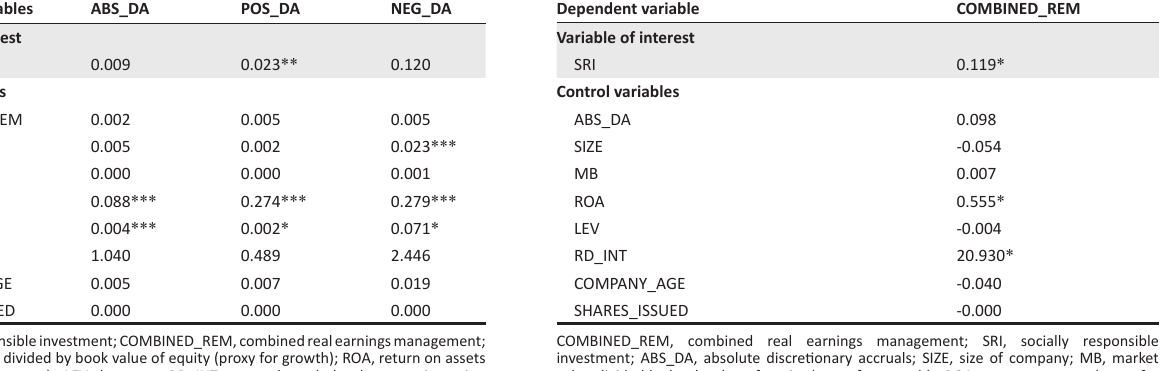
TABLE 4: Accrual-based earnings management on corporate social responsibility performance. Dependent variables